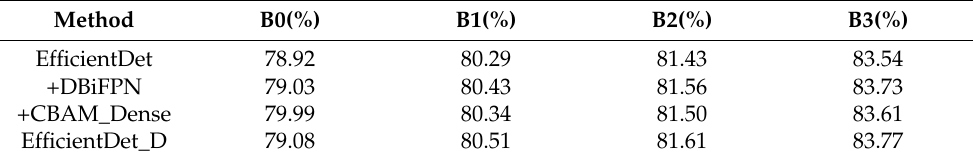
Table 2. Detection MAP result.